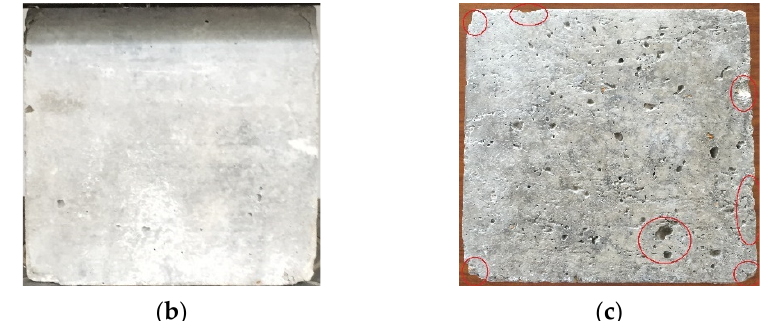
Figure 3. Surface changes in concrete after different dry and wet cycle inspection periods. ( a ) 5 months, ( b ) 15 months, ( c ) Surface pits and damage.